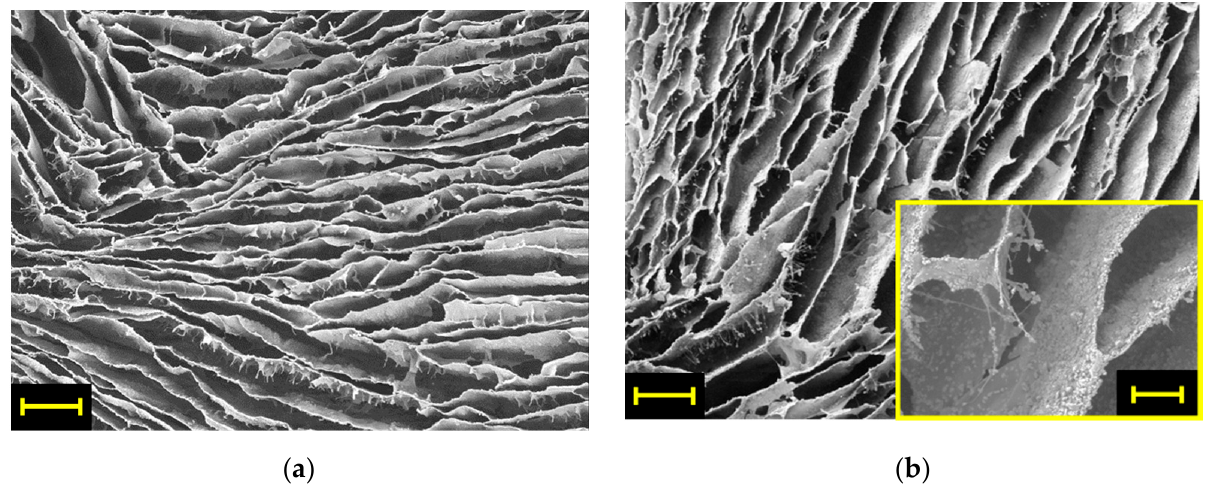
Figure 1. Representative SEM micrographs of ( a ) CS and ( b ) CS–ZX aerogels. Scale bar is 200 µm (the bar in the inset of ( b ) is 50 µm).